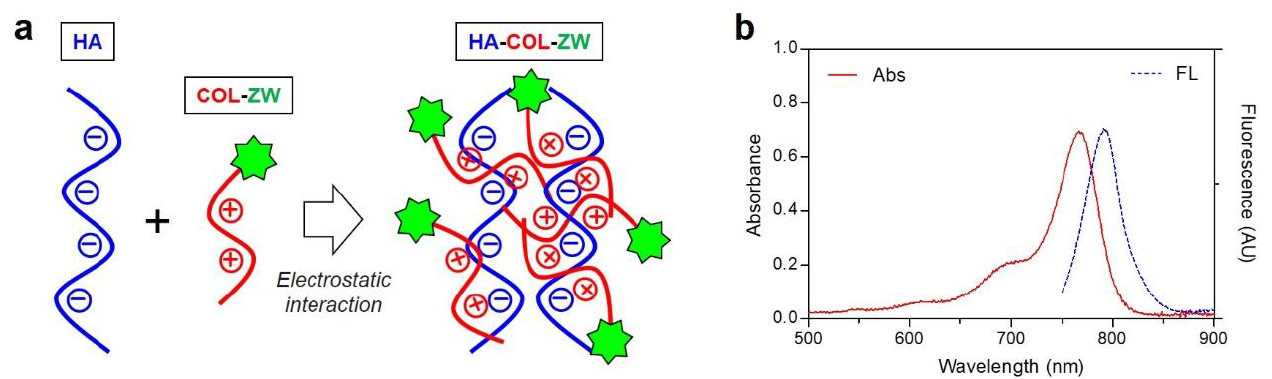
Figure 2. ( a ) Hypothetical scheme of the HA-COL-ZW nanocomplex. The nanocomplex formation of electrostatic interactions between negatively charged HA and positively charged COL-ZW. ( b ) Absorption and fluorescence emission spectra of HA-COL-ZW measured in PBS, pH 7.4.